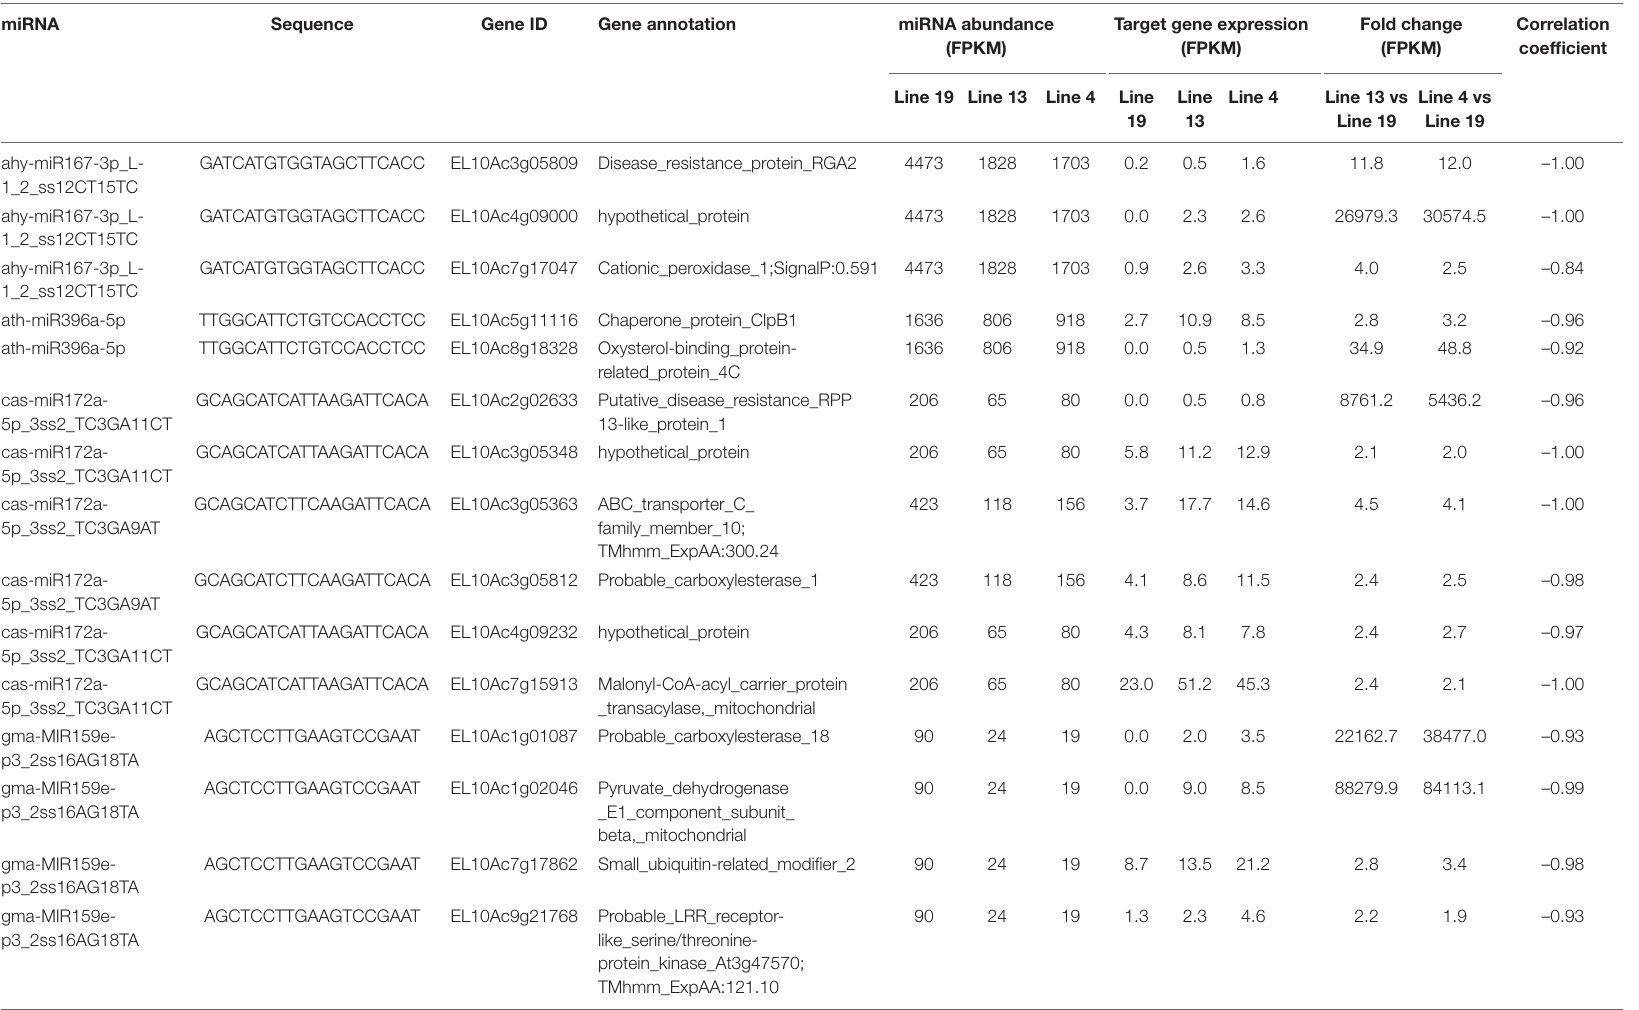
TABLE 2 | Sugar beet miRNAs that showed < 2-fold expression in the apical leaves of BCTV resistant (13, 4) vs. susceptible (19) lines at 2 dpi and effect on corresponding sugar beet target gene expression. miRNA Sequence Gene ID Gene annotation miRNA abundance